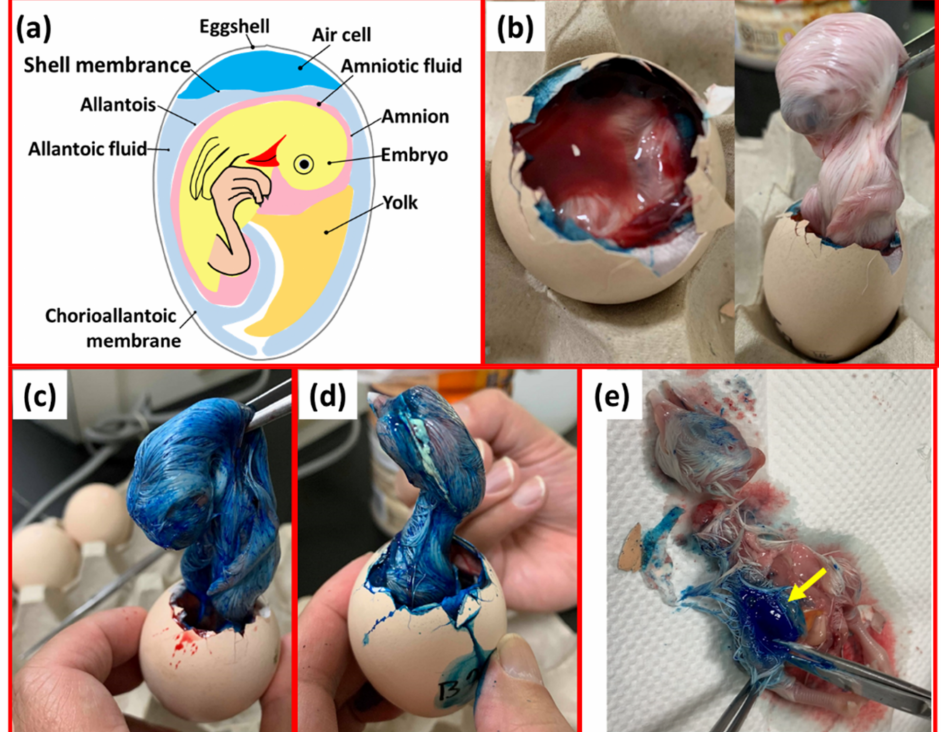
Figure 3. Simulated injection results ( a ) Spatial relations within an embryonated chicken egg; ( b ) 5 MPa needleless injection: the ink did not penetrate the inner egg membrane. ( c ) 6 MPa and ( d ) 7 MPa: blue pigment passed through the egg membrane, staining the surface of the chicken embryo. ( e ) 8 MPa: blue pigment has been injected into the muscle tissue of the chicken